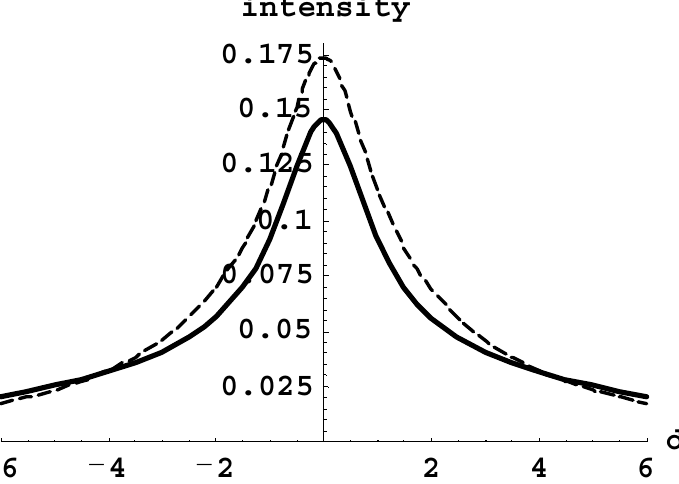
Figure 14. Theoretical profiles of the entire Ly-alpha line, corresponding to the observation perpendicular to the REB velocity without the polarizer, at N e = 10 15 cm − 3 and T e = 2 eV. The profiles were calculated using Equations (8.10)–(8.13) and presented versus the scaled detuning ∆ ω / Γ π denoted as d. The solid curve corresponds to γ = 2 1/2 , while the dashed curve – to γ = 1 [82]. The above theoretical results represented the Stark broadening of hydrogen/deuterium spectral lines only by a REB without allowing for other factors affecting the lineshapes. This was done in the second part of [82], the authors removed this restriction, as follows 4